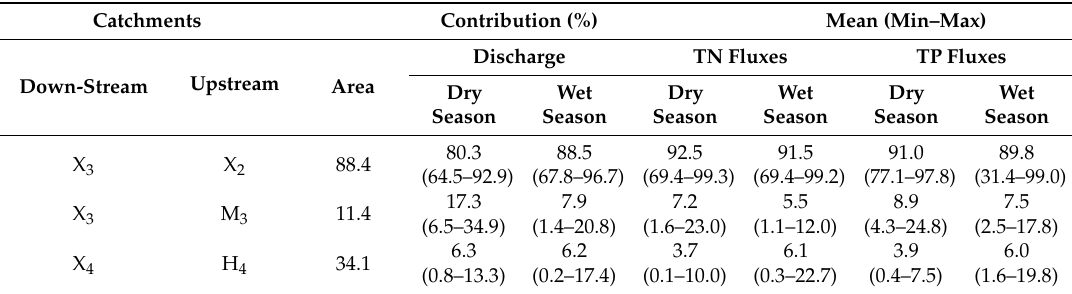
Table 5. The relative contribution of area, discharge and nutrient flux in the upstream X 2 , M 3 , H 4 catchments to the downstream X 3 and X 4 catchments.